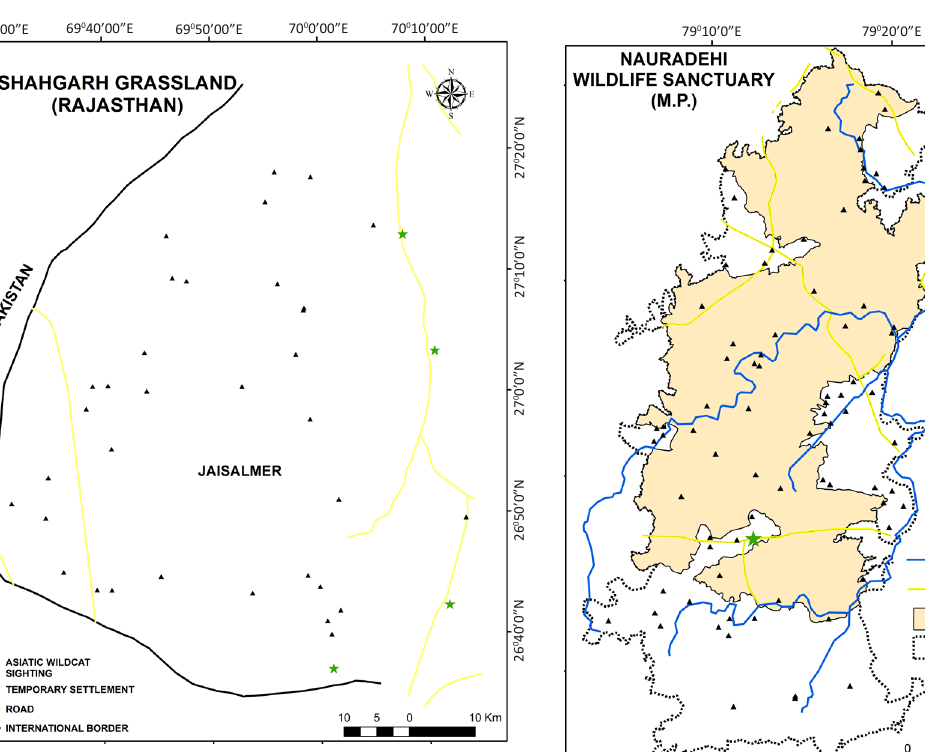
Figure 2b. Sighting locations in Shahgarh grasslands.